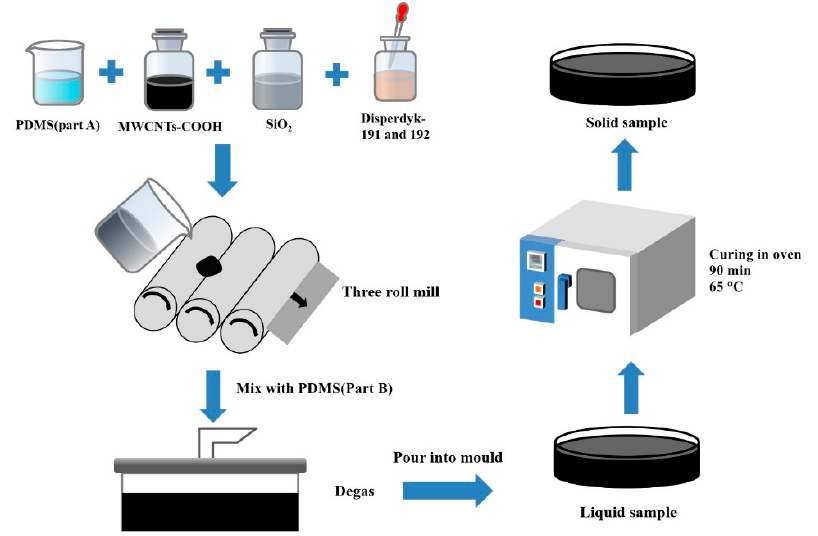
Figure 1. Schematic illustration of the fabrication procedures.